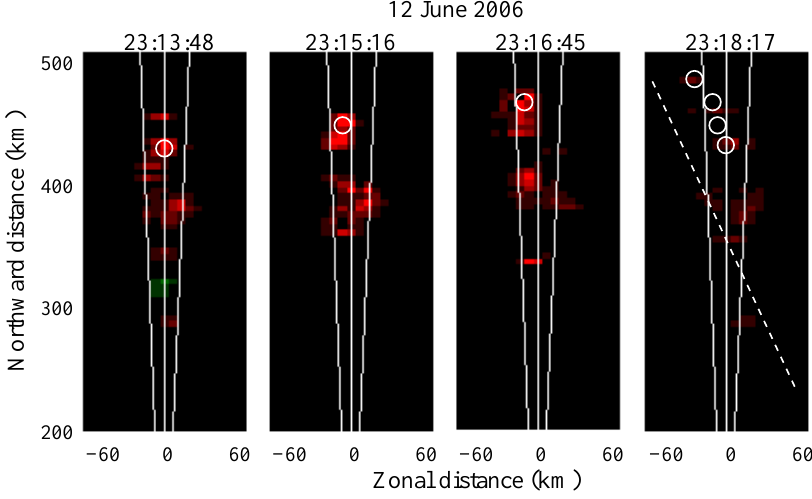
Fig. 6. Sequential images of echoes from beam 2 cluster C from 23:13:48 to 23:18:17JST on 12 June 2006. The images are projected on a horizontal plane at an altitude of 300km along the geomagnetic field line. White circles in the rightmost panel show the approximate positions of echo patches in these four images as also indicated by circles in other panels. The dashed line in the rightmost panel indicates the wavefront direction of the MSTID (at an arbitrary phase).